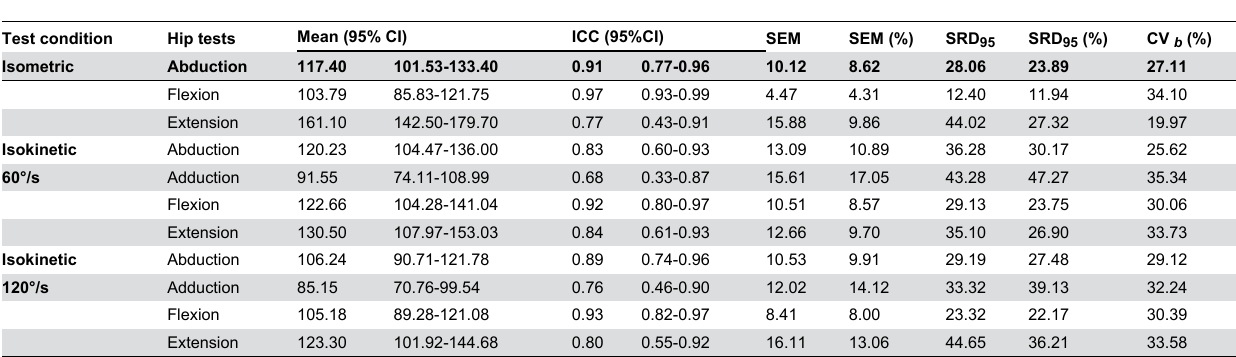
Table 1. Reliability, variability and clinical important change of hip torque measures using Biodex dynamometer.